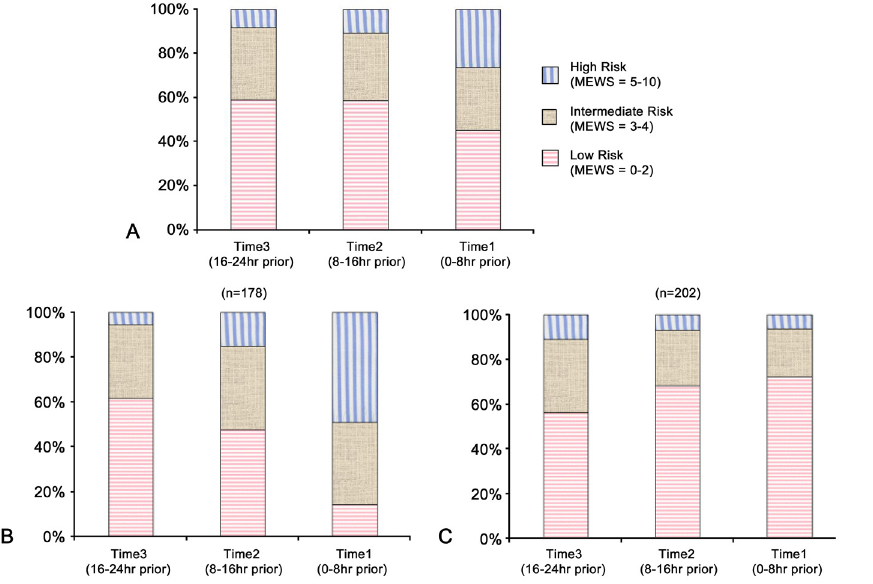
Fig 3. Distribution of MEWS Risk Groups According to Time Point: A — All patients N = 380) B — Increasing MEWS Group (N = 178) C — Non-increasing MEWS Group (N = 202).